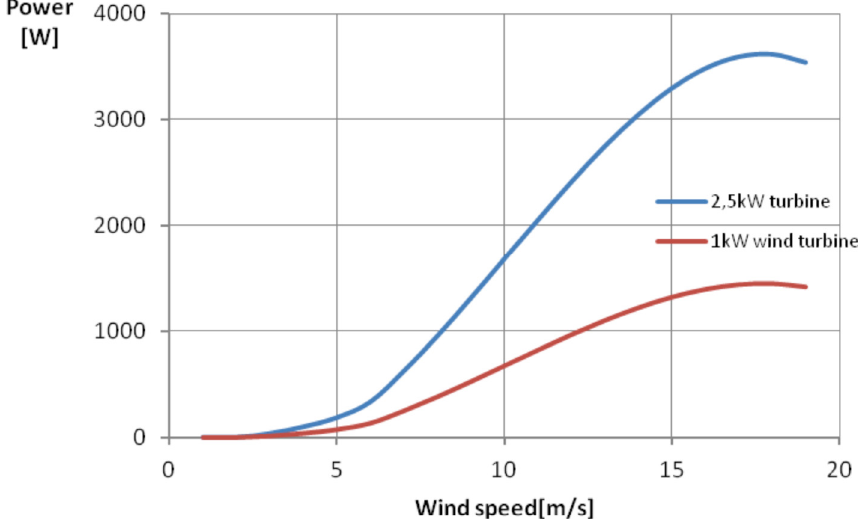
Fig. 2. Typical 2.5 kW wind turbine power curve and normalized power curve.